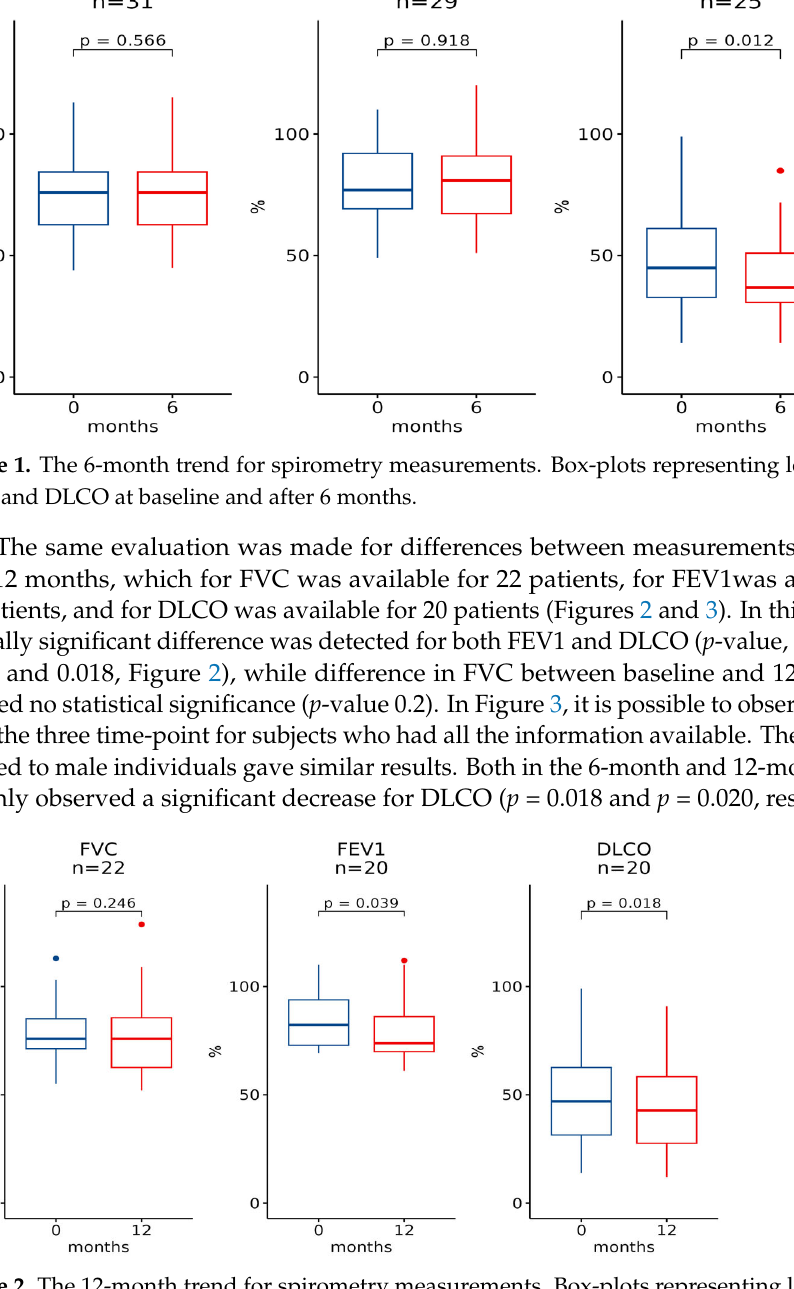
Figure 3. Trend for spirometry measurements between 0 and 12 months. Dots represent the median value, bars indicate the first (Q1) and the third (Q3) quartiles. Considering individuals that took NTD for at least 4 months, life status information was available for 50 of them, with median follow ‐ up of 17 months. The overall survival was 80.1% (95% CI [68.7, 80.1]) at one year, 60.8% (95% CI [47.0, 78.6]) at two years, and 38.4% (95% CI [24.8, 59.4]) at three years (Figure 4).